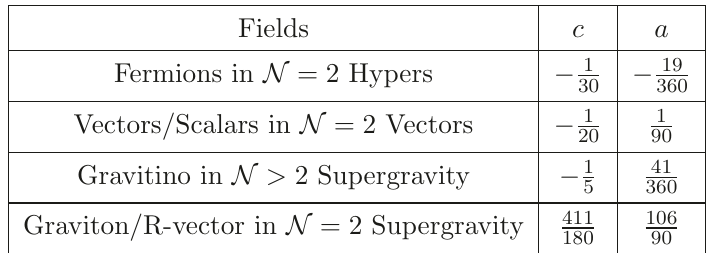
2 supergravity theory. Each N ≥